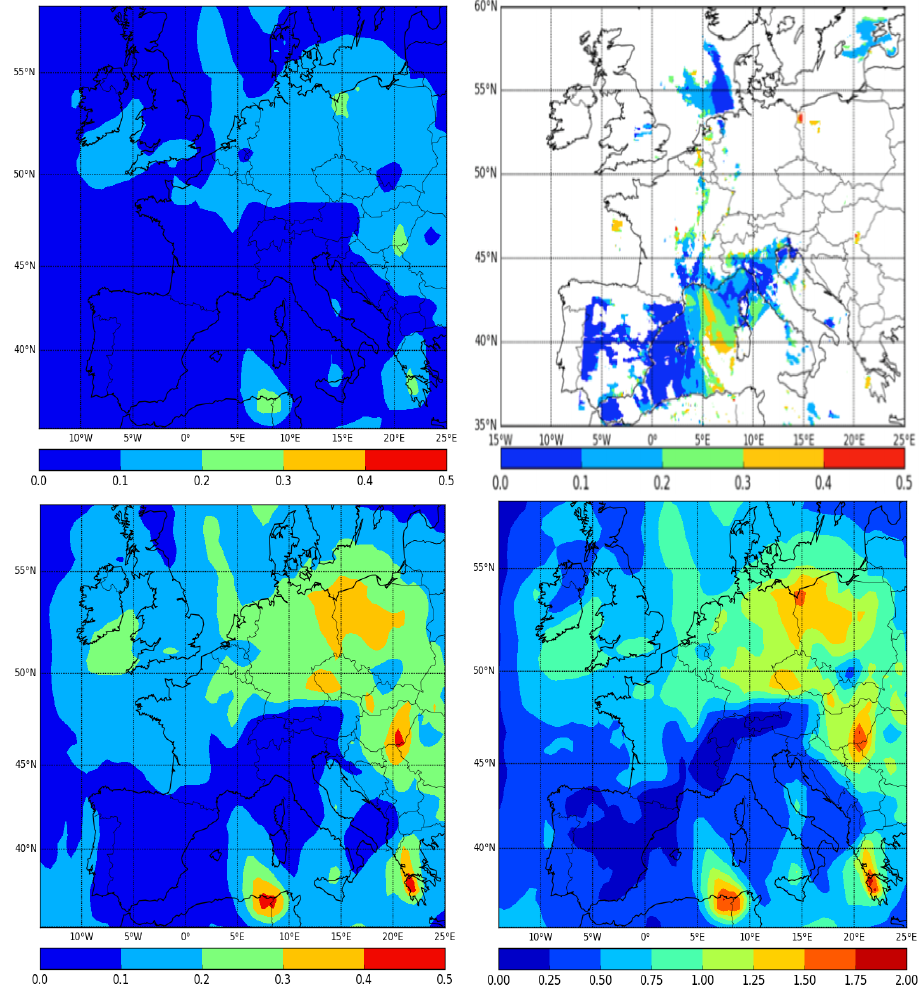
Figure 4. ( Upper left panel ): Modeled AOD Chim (first guess). ( Upper right panel ): MODIS AOD obs retrievals. ( Lower left panel ): the analysis of AOD field AOD ana . ( Lower right panel ): Ratio of AOD analysis to the AOD first